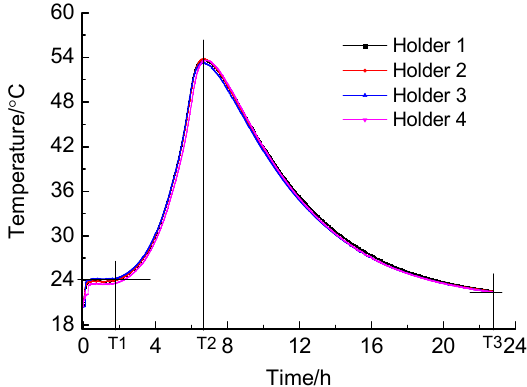
Figure 5. The consistency of the testing results for the blank sample in different insulative holders.